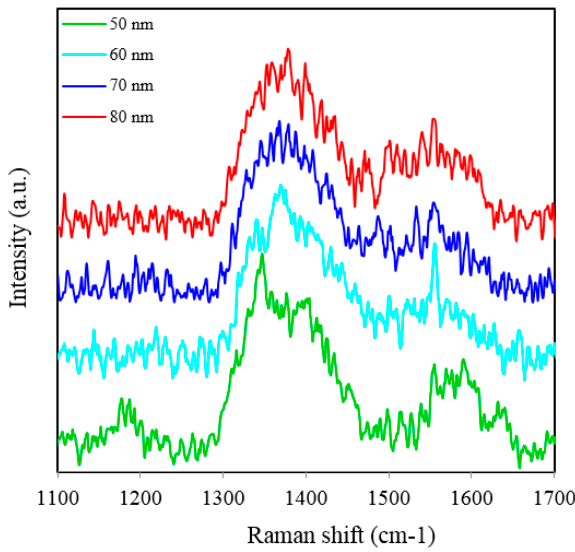
Figure 7. SERS spectra of 8 × 10 − 5 M solution of Rh6G dye adsorbed on the surface of 150 nm nanoporous substrate coated with 50, 60, 70 and 80 nm gold films measured with 3 s integration time.